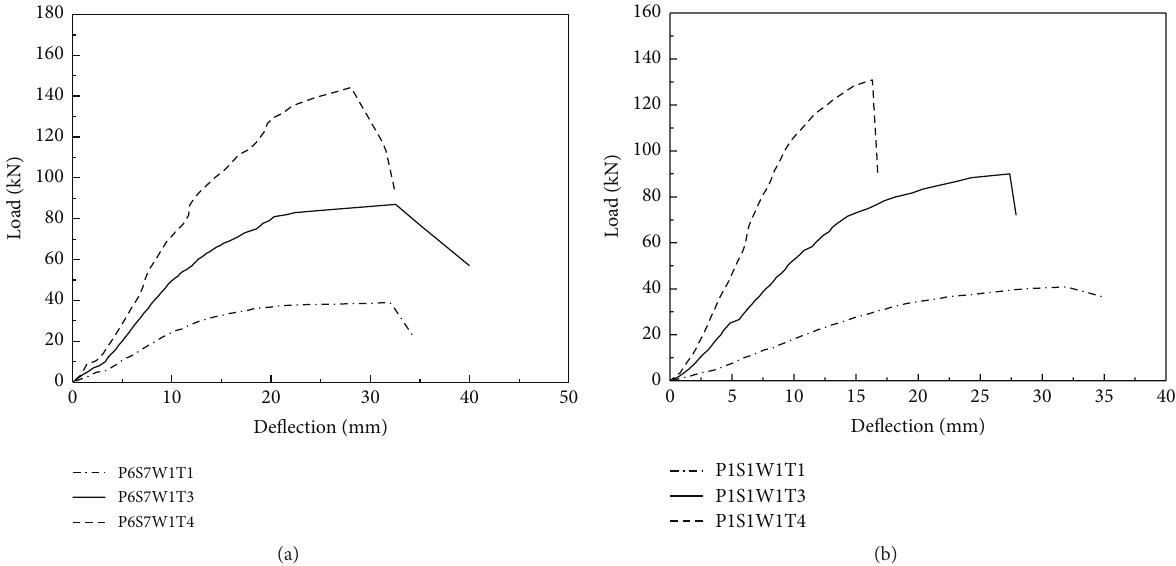
Figure 6: The influence of face sheet thickness: (a) 𝑡 𝑤 = 1.6mm, 𝑠 = 75 mm, and 𝜌 = 60 kg/m 3 and (b) 𝑡 𝑤 = 1.6mm, 𝑠 = 125 mm, and 𝜌 = 100kg/m 3 .